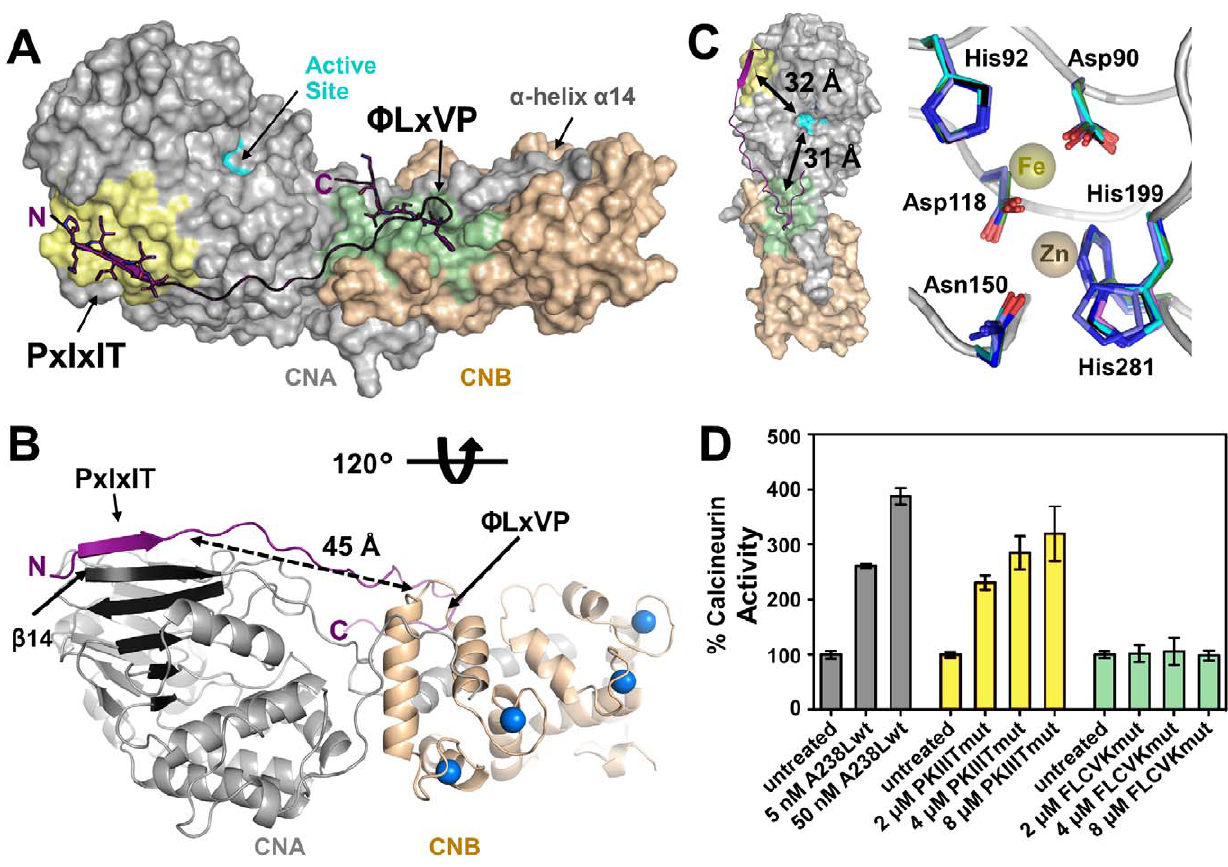
Figure 2. The CN active site is fully accessible in the CN-A238L complex. (A) Overview of the CN-A238L complex. CNA (gray, surface representation) interacts via helix a 14 with CNB (beige, surface representation). The CNA active site is highlighted in cyan, with PxIxIT and LxVP binding pockets shown in yellow and green, respectively. A238L is shown as a cartoon representation (purple), with the PxIxIT (PKIIIT) and LxVP (LCVK) substrate binding motifs highlighted as sticks. (B) Cartoon representation of the CN-A238L complex. Structure is rotated 120 u about the x -axis relative to (A); all colors as in (A); blue spheres representing four Ca 2 + atoms in CNB. CNA b -sheet1 is shown in dark grey. The N-terminal b -strand formed by the A238L PxIxIT motif complements b -strand14 of CNA and thus extends b -sheet1. (C, left) CN-A238L illustrated as in (A), with the distances between the CN active site and the PxIxIT and LxVP binding grooves indicated by arrows ( , 32 A˚ and , 31 A˚, respectively). (C, right) Overlap of the catalytic residues from the CN-A238L complex (black), apo-CN (cyan, PDBID 1AUI), CN-AKAPpeptide (dark blue, PDBID 3LL8), CN- PVIVITpeptide (green, PDBID 2P6B), CN-Cyclosporin (light blue, PDBID 1M63), and CN-FK506 (pink, PDBID 1TCO). Catalytic residues of CNA are shown as sticks and labeled (Asp90, His92, Asp118, Asn150, His199, His281). Fe 3 + and Zn 2 + ions from 1AUI are shown as spheres. (D) The rate of pNpp hydrolysis was measured in the presence of A238L (grey), A238L PKIIITmut (yellow), or A238L FLCVKmut (green). Assays were performed in triplicate using 10 mM pNpp, and error bars indicate one